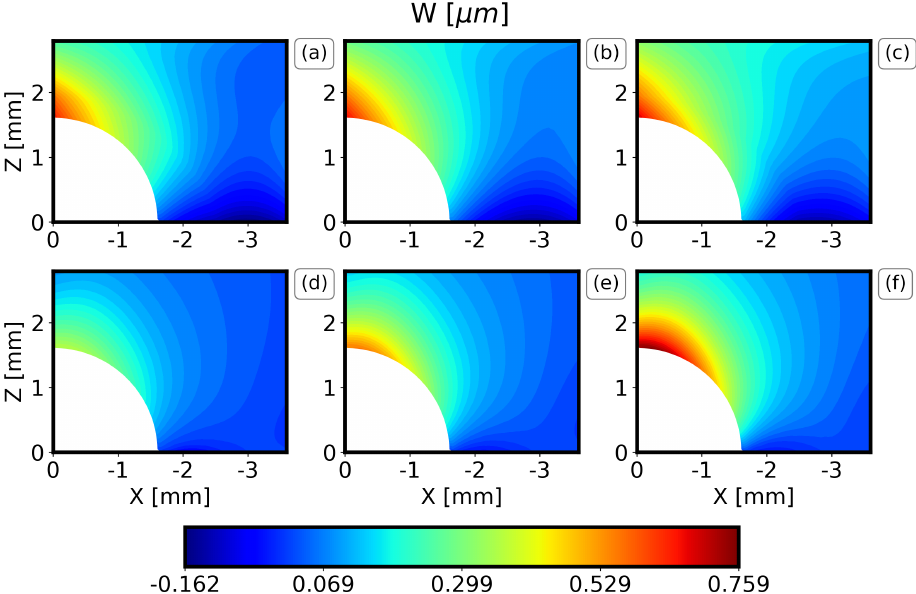
Figure 7. Comparison of DIC measurements and PC results for the W − displacement field and a drilling depth 1.2 mm. ( a ) Expected experimental value minus one standard deviation, ( b ) expected experimental value, ( c ) expected experimental value plus one standard deviation, ( d ) expected PC value minus one standard deviation, ( e ) expected PC value, ( f ) expected PC value plus one standard deviation.